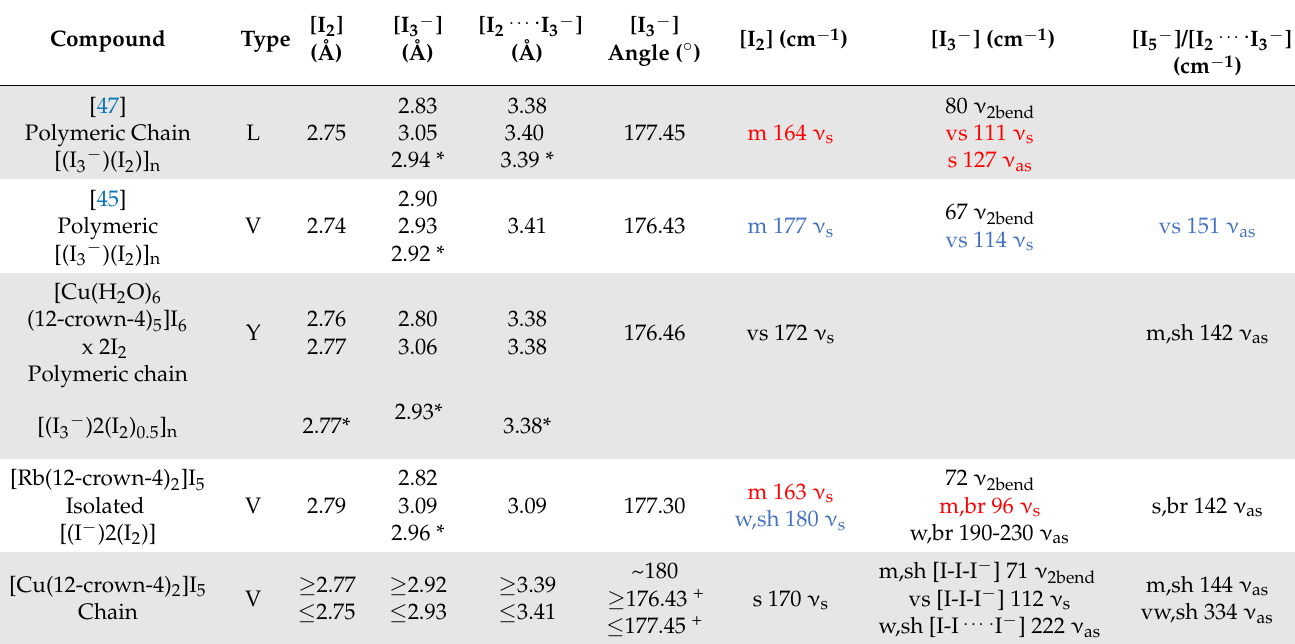
* average. + expected bond angles for asymmetric triiodide units. ν = vibrational stretching, s = sym ‐ metric, as = asymmetric, s = strong, m = intermediate, sh = shoulder, v = very, w = weak, and br = broad. Red/Blue shift in comparison to other bands in Table 3.